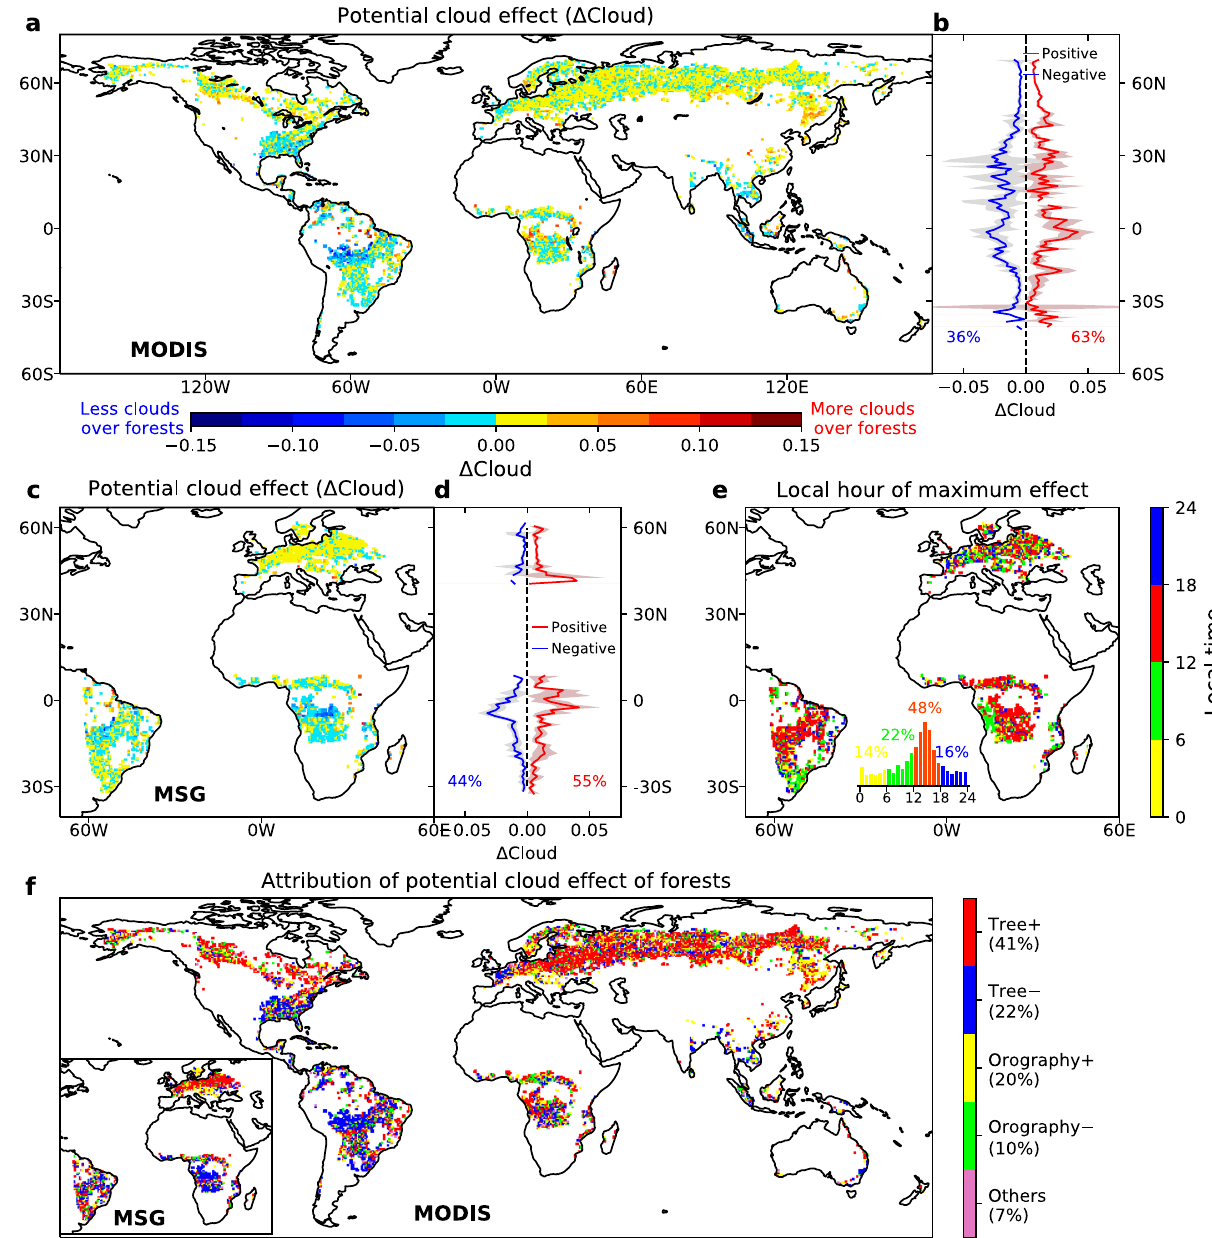
Fig. 1 The potential effects of forests on June-August (JJA) cloud cover fraction and their attribution. The potential effect is de fi ned as the differences in cloud cover fraction between forests and nearby non-forest ( Δ Cloud) from MODIS and MSG satellites that detect clouds. a Potential effects of forests on cloud cover fraction based on MODIS data from 2002 to 2018 (overpass at 13:30 local time) and b their latitudinal patterns with cloud enhancement and inhibition effects separated. c , d Potential effects of forests on cloud cover fraction based on hourly MSG data from 2004 to 2013 (overpass at 14:00 local time) and e the timing of the maximum effect during a day. The numbers in panels b and d show the percentage of cloud enhancement (red) and inhibition (blue). f Attribution of cloud effects of forests to tree cover and elevation based on MODIS and MSG data. The fi ve attribution categories include tree cover induced cloud increase (Tree + ) and decrease (Tree − ), orography induced cloud increase (Orography + ) and decrease (Orography − ), and other unexplained effects. The percentage of each attribution category is calculated based on the MODIS